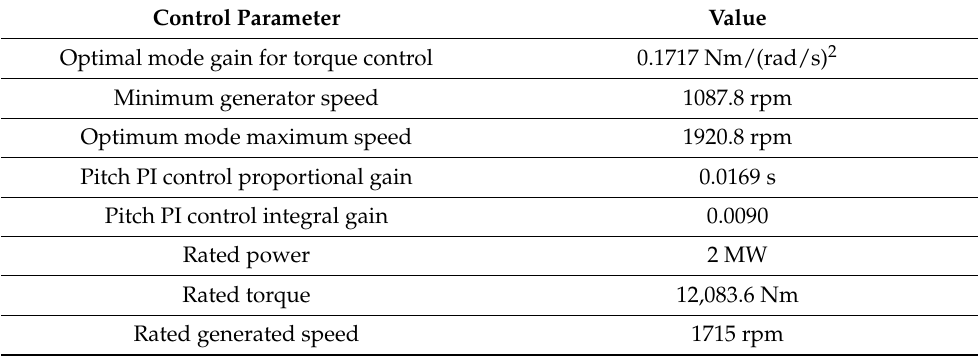
Table 2. Summary of control parameters.